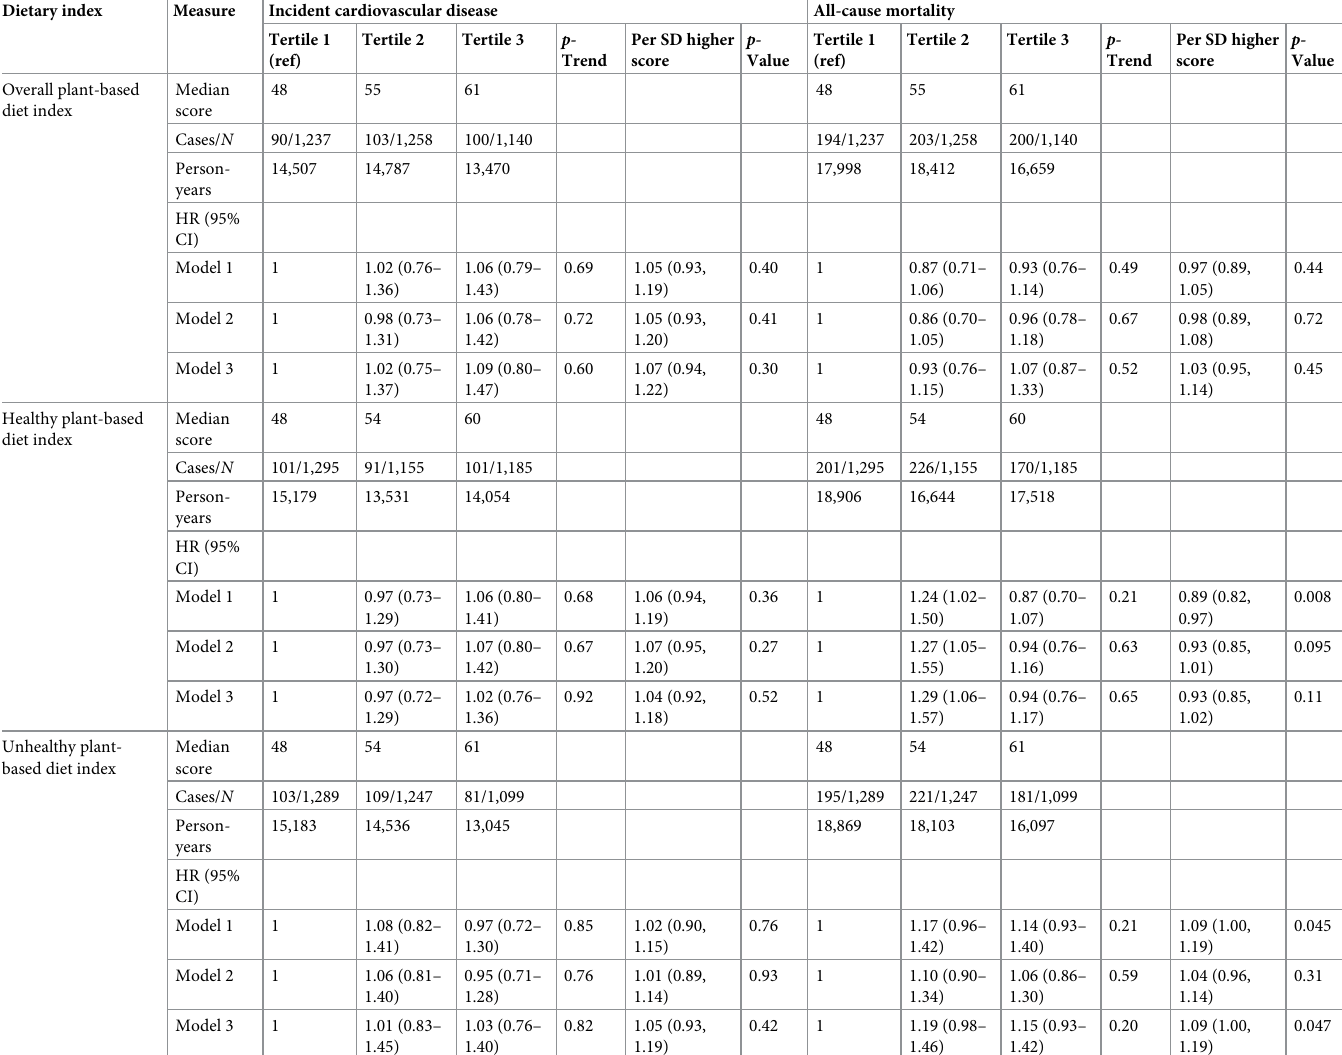
Table 3. Hazard ratios (95% confidence intervals) of incident cardiovascular disease and all-cause mortality among dietary patterns for progressively adjusted models. Dietary index